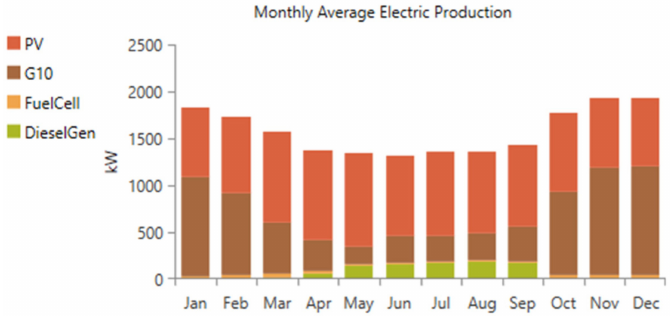
Figure 9. Monthly average electric